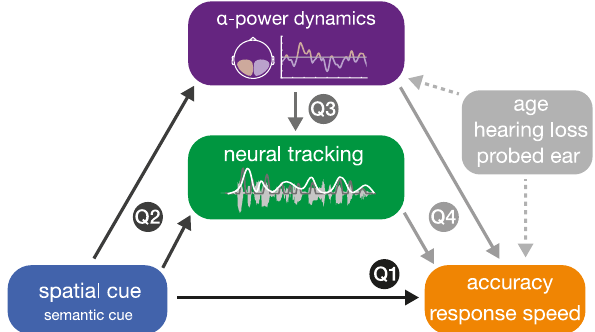
Fig. 1 Schematic illustration of addressed research questions.